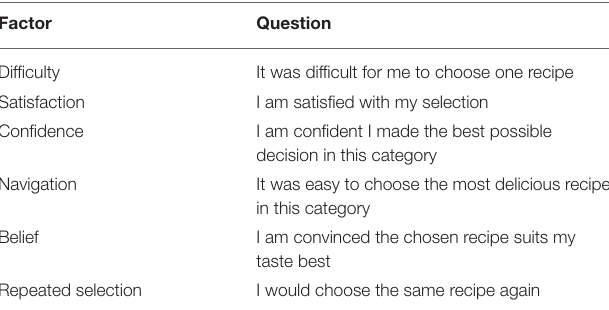
TABLE 6 | Questions of the post-choice questionnaire with the corresponding abbreviation and